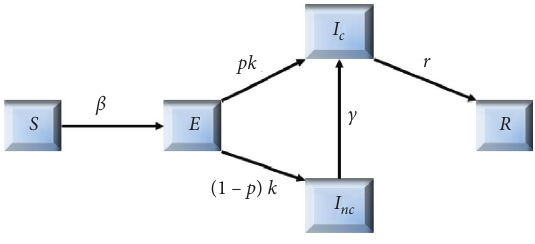
Figure 1: Transfer